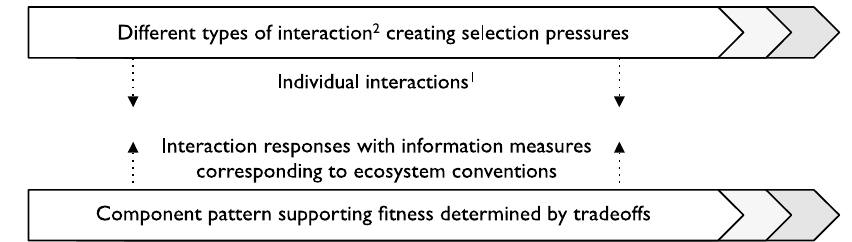
Figure 1. Levels of interaction and fitness.